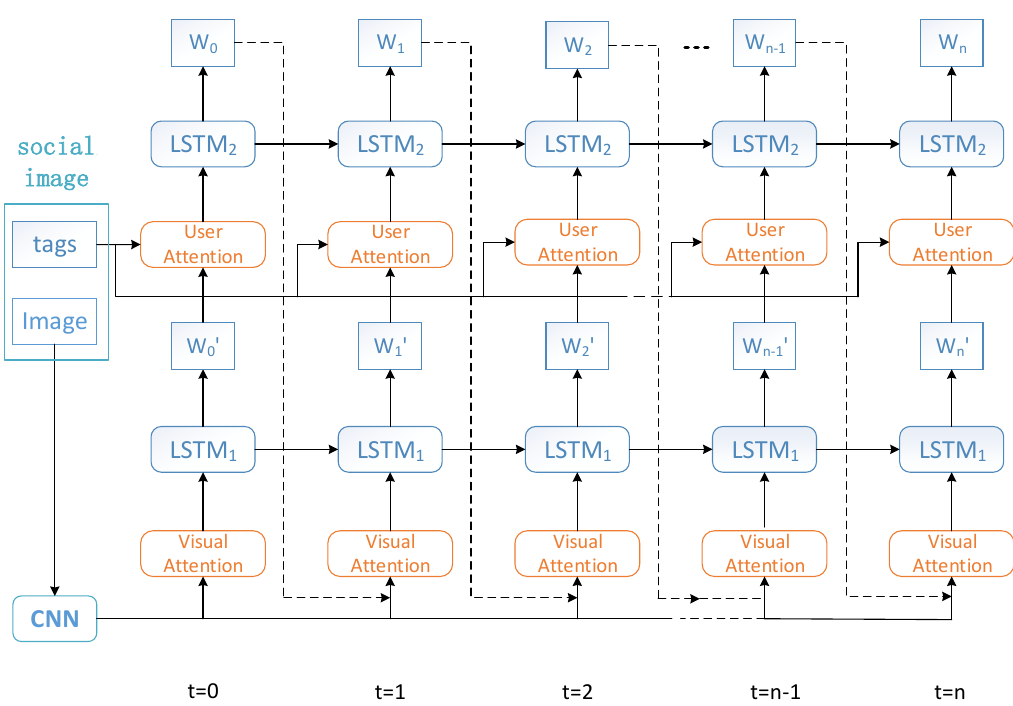
Figure 3. The architecture of the proposed dual attention model. The image feature is fed into the visual attention model to generate the visual word W (cid:48) based on the hidden state h 1 of LSTM 1 . W (cid:48) and tags are then combined to generate word W by user attention based on the hidden state h 2 of LSTM 2 . The user attention modal is exploited to emphasize the users’ attentiveness and to eliminate the influence of noisy